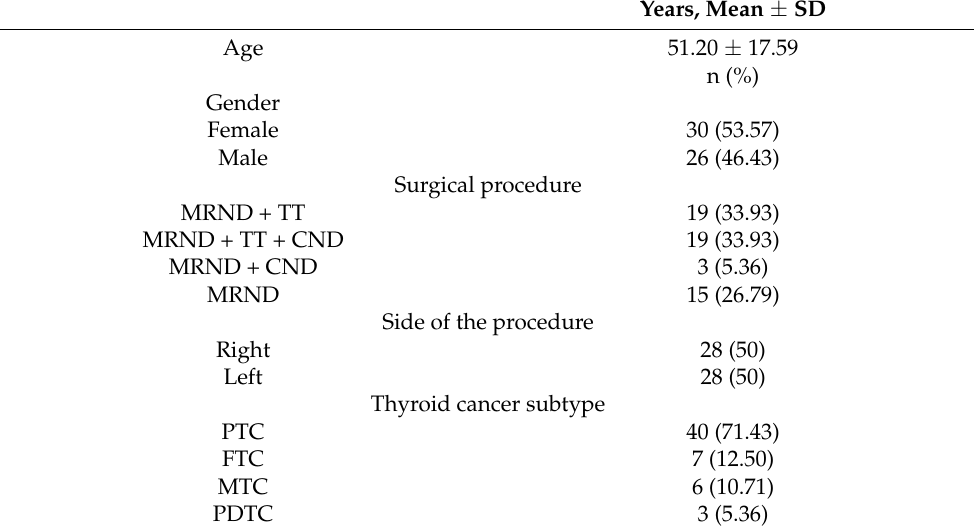
Table 1. Patient demographic and clinical characteristics. Modified Radical Neck Dissection (MRND), Total Thyroidectomy (TT), Central Neck Dissection (CND), Papillary Thyroid Cancer (PTC), Fol- licular Thyroid Cancer (FTC), Medullary Thyroid Cancer (MTC), Poorly Differentiated Thyroid Cancer